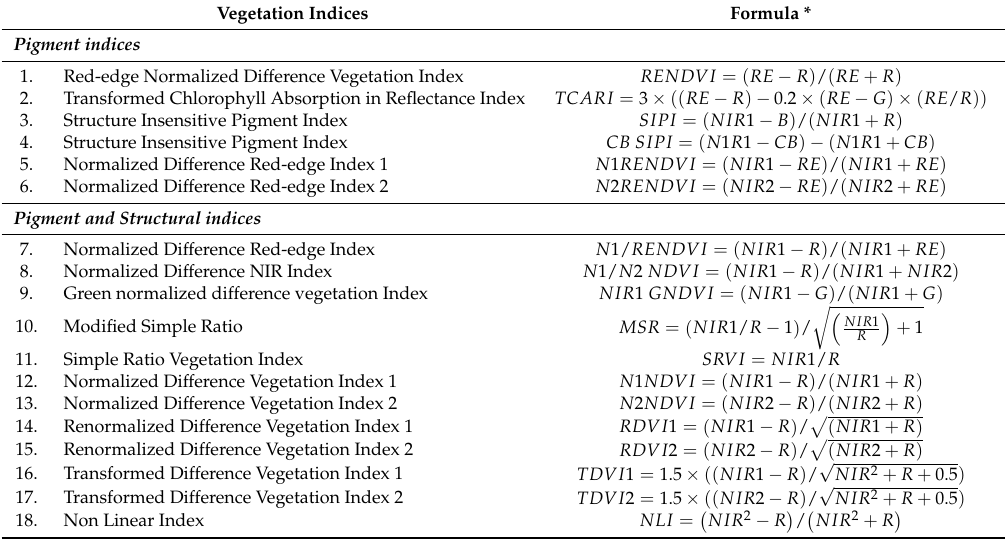
Table 2. Vegetation indices and their formulations used in this study